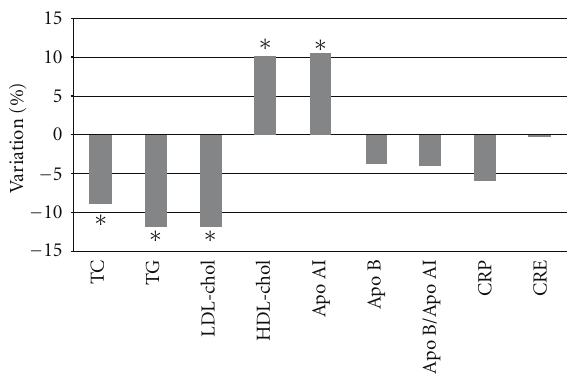
Figure 2: Variations of di ff erent parameters in argan oil groups after three weeks of interventions. Abbreviations: Apo AI: apolipoprotein AI; Apo B: apolipoprotein B; CRE: creatinine; CRP: C-reactive protein; HDL-Chol: high density lipoprotein cholesterol; LDL-chol: low density lipoprotein cholesterol; TC: total cholesterol; TG: triglycerides; ∗ significantly di ff